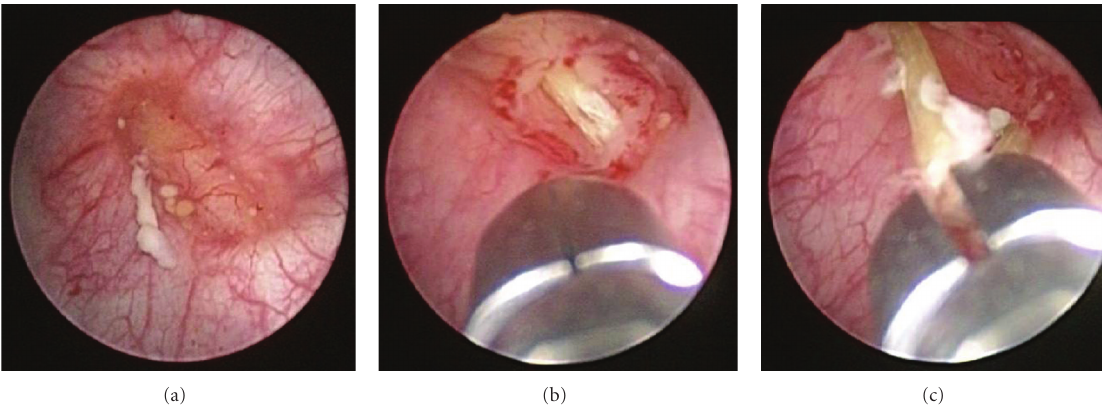
Figure 2: Cystoscopic view. A protruding mass with outflow of pus from a shallow recess on the top (a). A linear structure was seen after a cold cup biopsy of the mucosa was performed (b). The structure was removed using forceps